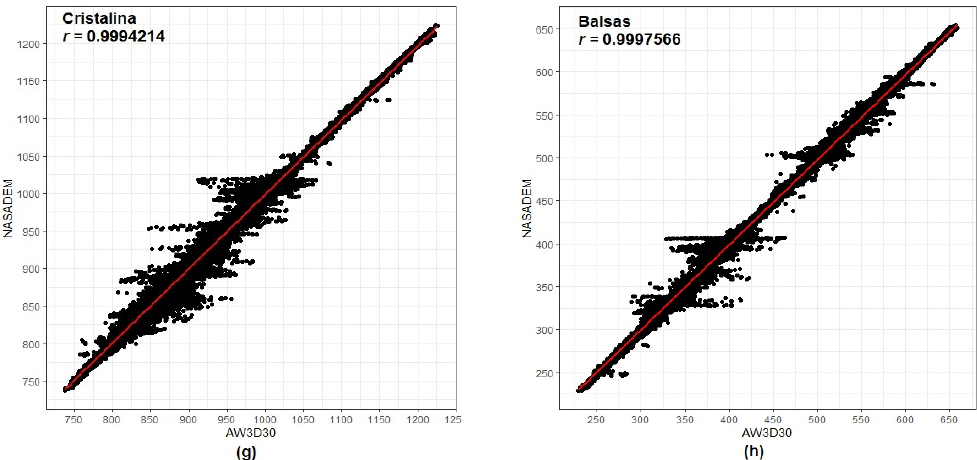
Figure 10. Relation between NASADEM_HGT and AW3D30 for the agricultural areas of Sapezal ( a ), Rio Verde ( b ), São Desidério ( c ), Maracaju ( d ), Formosa do Rio Preto ( e ), Primavera do Leste ( f ), Cristalina ( g ), and Balsas ( h ) municipalities.